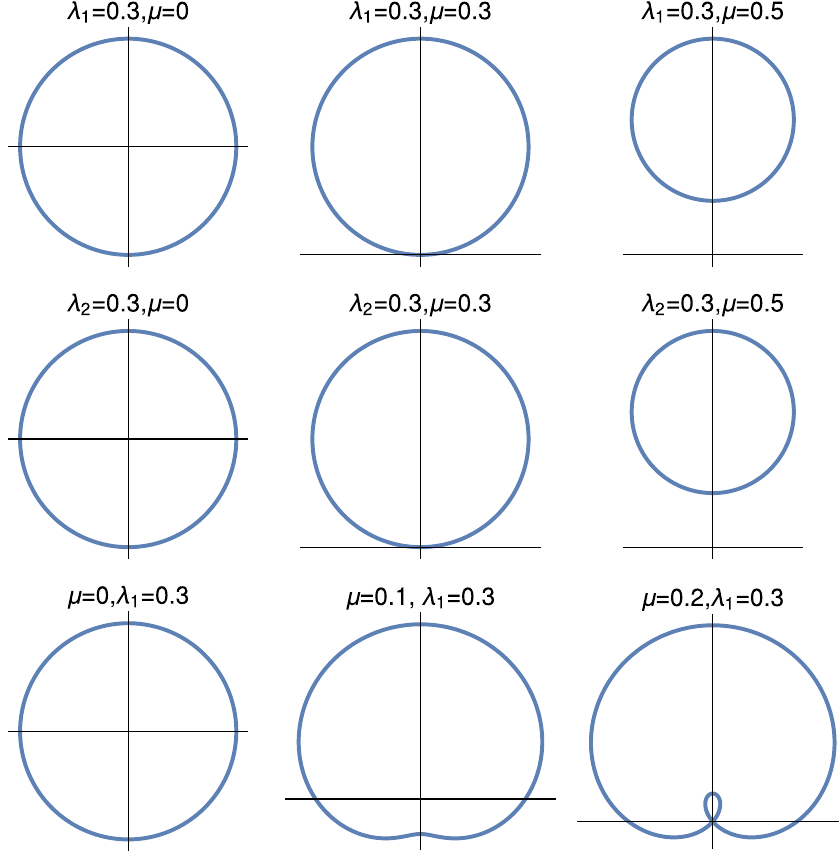
Figure 2. Parametric plot of the vector χ ˆ k ( ) . The upper, middle and lower rows of this figure are λ 1 ≠ 0, λ 2 = 0; ≠ 0 and λ = 0, and λ =− μ λ 2 1 2